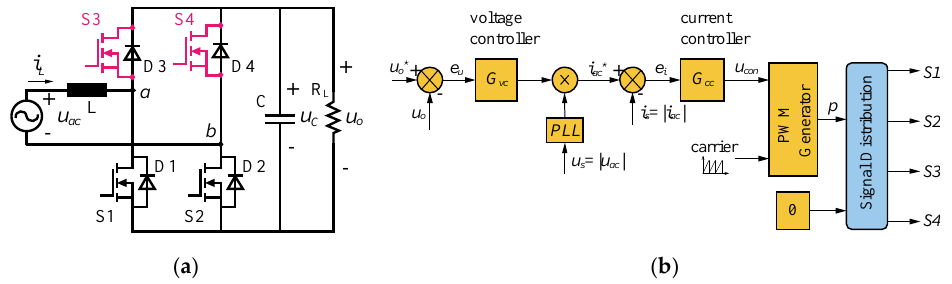
Figure 9. Fault tolerant control topology and control method. ( a ) Proposed fault tolerant topology with two additional switches; ( b ) block diagram of the fault tolerant control method with signal